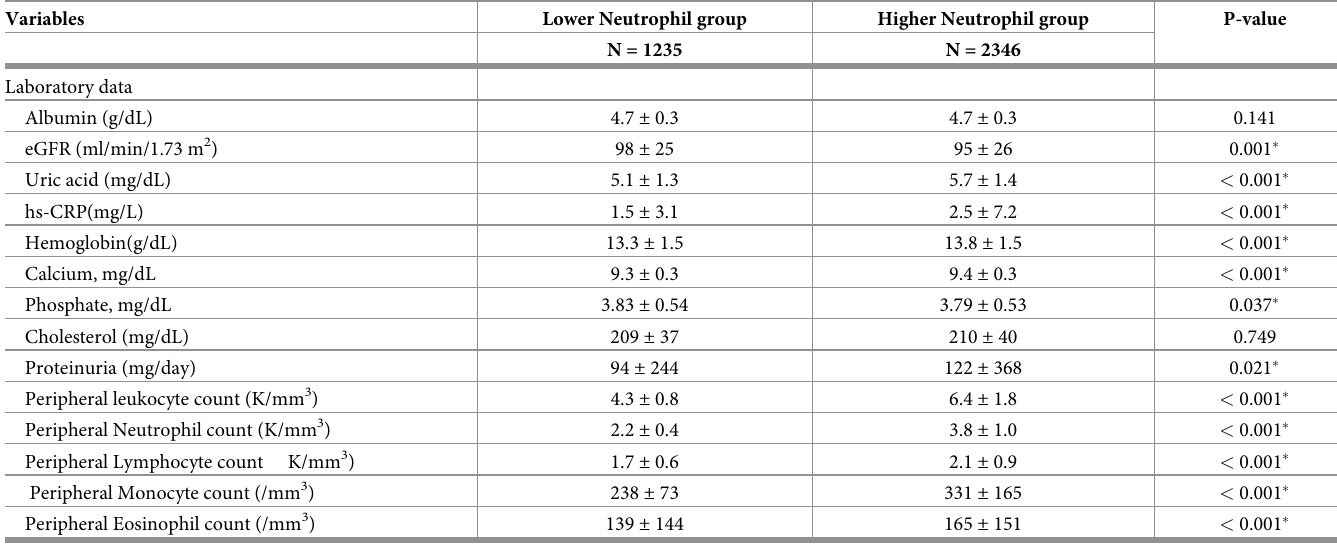
Table 8. Laboratory data of study population with lower and higher peripheral neutrophil